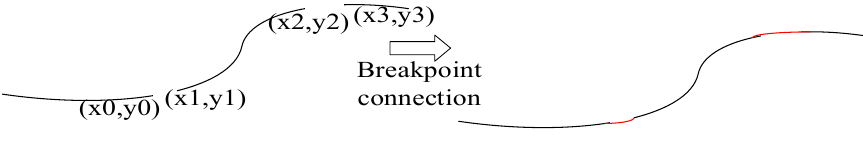
Figure 5. Breakpoint connection process.